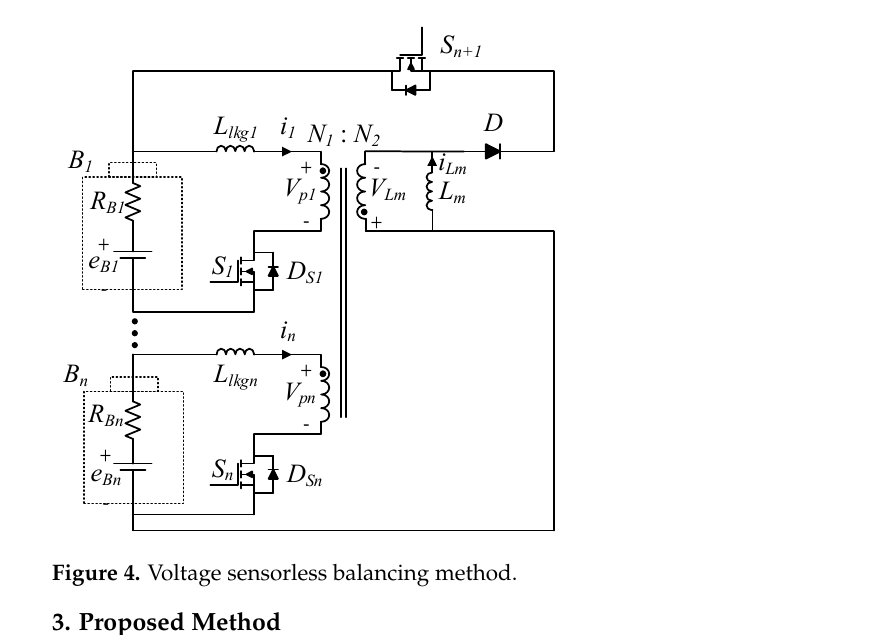
Figure 3. Voltage sensorless balancing method.